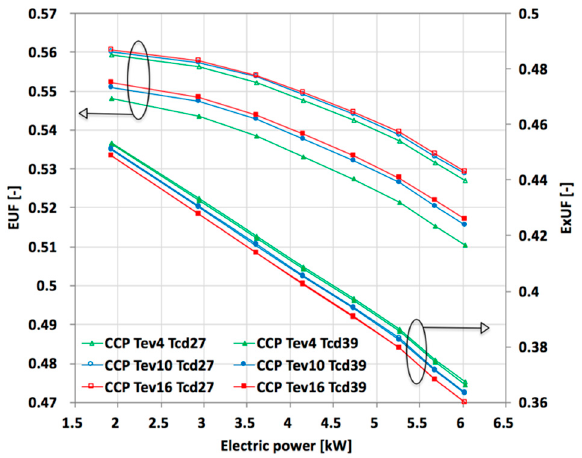
Figure 8. EUF and ExUF vs. electric power for CCP mode.